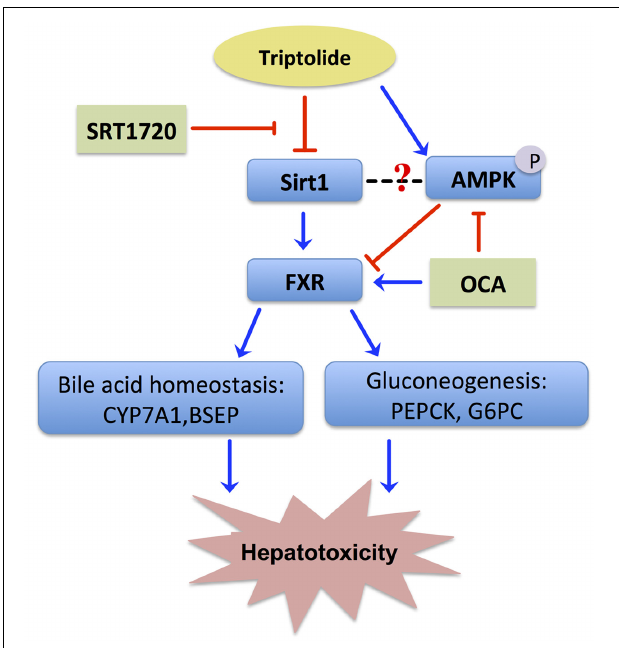
FIGURE 7 | Proposed signaling pathways involved in TP-induced hepatotoxicity. TP suppressed the FXR/SHP pathway via inhibiting the Sirt1 activity, which led to dysregulation of the expression of FXR-targeted genes involved in bile acid homeostasis and gluconeogenesis. Both Sirt1 agonist, SRT1720, and FXR agonist, OCA, reduced TP-induced disruption of hepatic metabolism and liver injury.